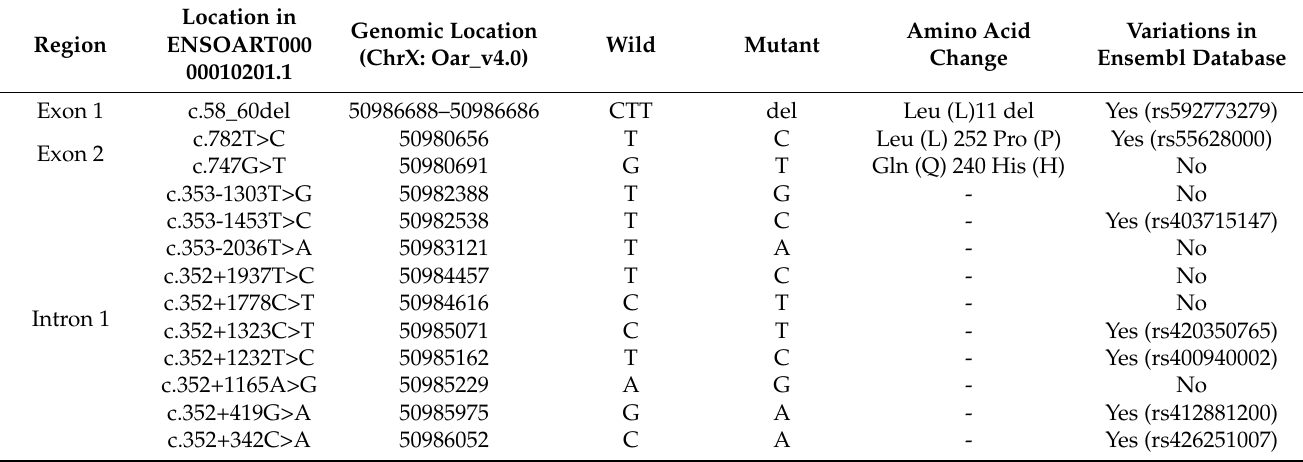
Table 2. The detailed information of 13 variations in the BMP15 gene in Luzhong